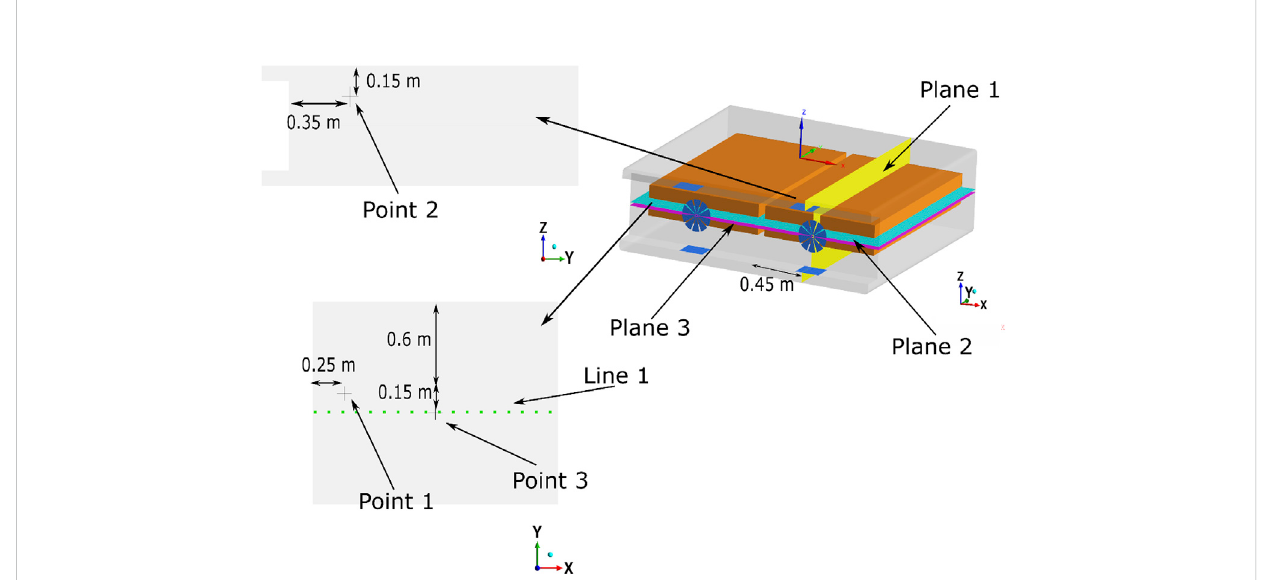
FIGURE 4 Sampling positions applied in the numerical experiments.